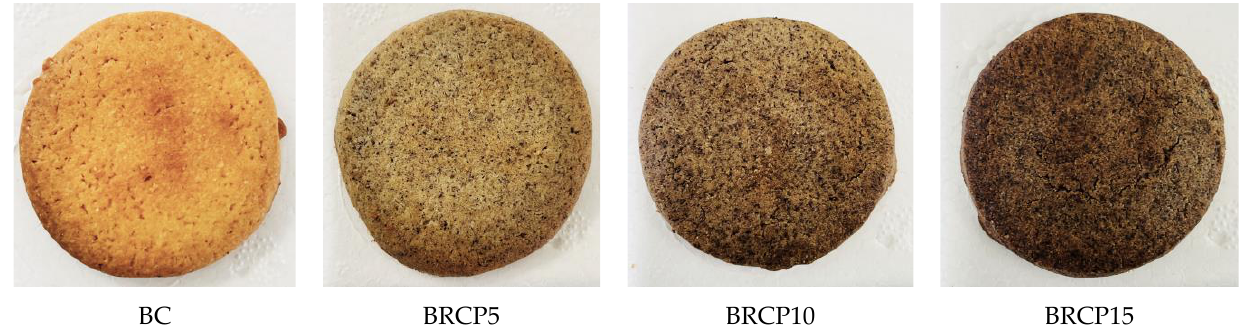
Figure 1. Biscuit enriched with infused roselle calyx powder